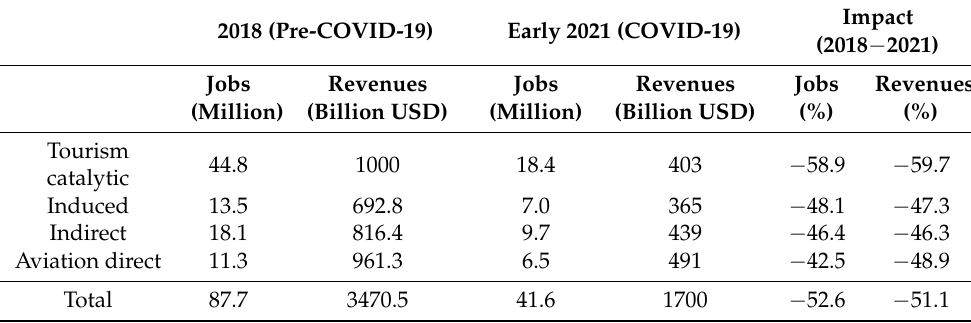
Table 3. Impact of COVID-19 on aviation-related jobs and